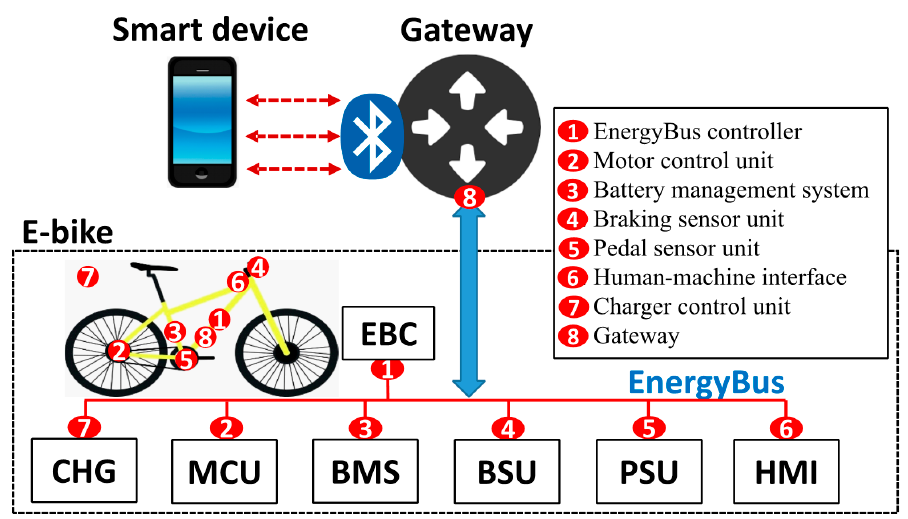
Figure 1. System overview.